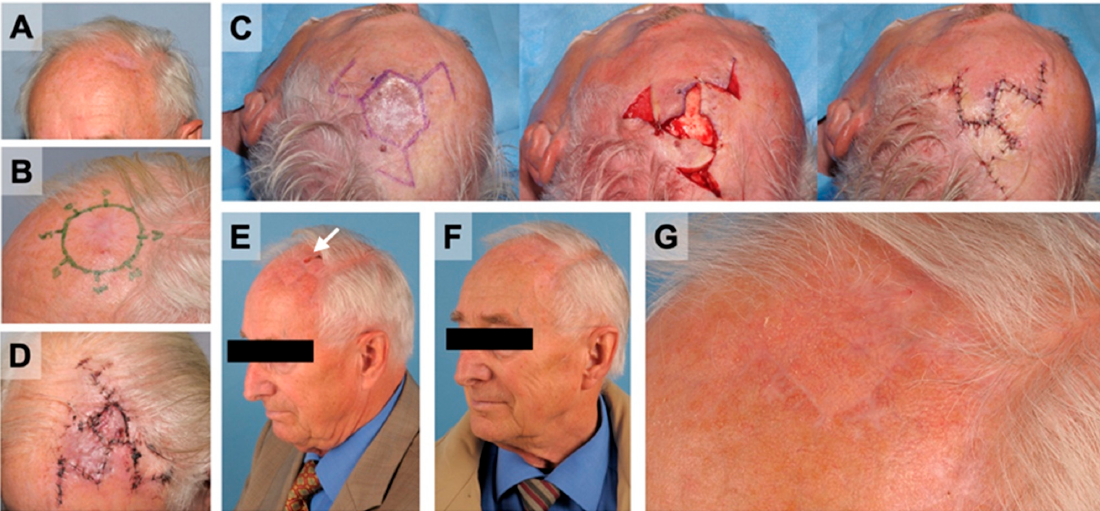
Figure 3. Triple-rhomboid flap for the reconstruction of the scalp in the frontotemporal region. ( A ) A 77-year-old male patient presented after resection of an AFX in an external hospital with positive margins in the frontotemporal area. ( B ) The patient was treated in a multistage approach, with temporary coverage to ensure tumor-free margins. The follow-up resection showed no residues of tumor tissue. ( C , D ) The resulting full-thickness scalp defect (middle) of 13.05 cm 2 was closed using a triple-rhomboid flap. ( E ) One month after the definitive resection, the patient presented with minimal wound dehiscence (arrow). ( F , G ) The three-month postoperative control showed satisfying aesthetic results without clinical signs of local